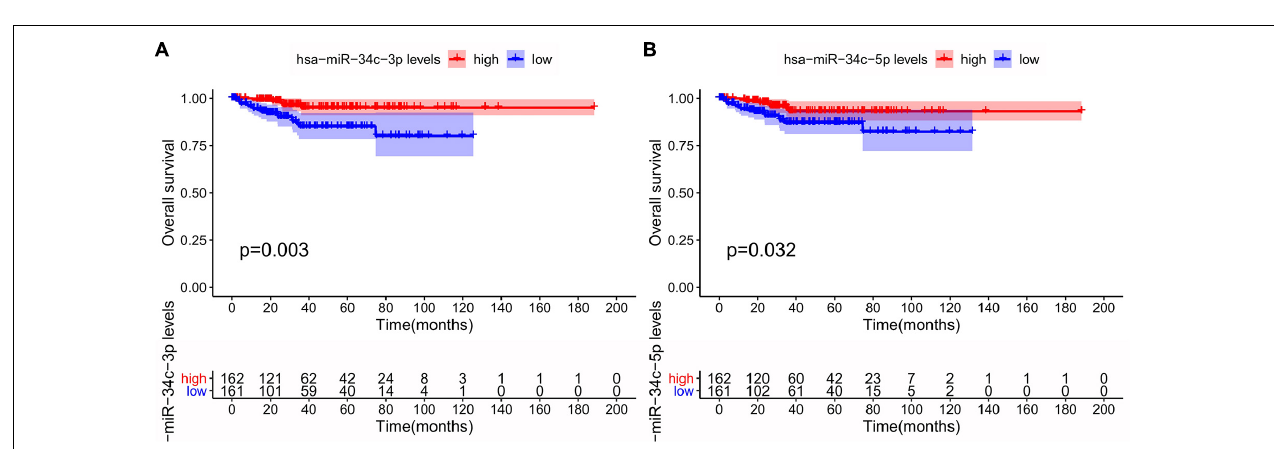
FIGURE 6 | The expression value of miRNAs in different groups in the GSE75968 database. This figure describes the expression value of miR-34c-3p (A) , miR-34c-5p (B) , and miR-34b-5p (C) in lymph node metastasis-positive and lymph node metastasis-negative groups in the GSE75968 database. N+, lymph node metastasis positive; N-, lymph node metastasis negative. Data were shown as mean ± SD. Individual data points were shown. * p < 0.05, ** p < 0.01.